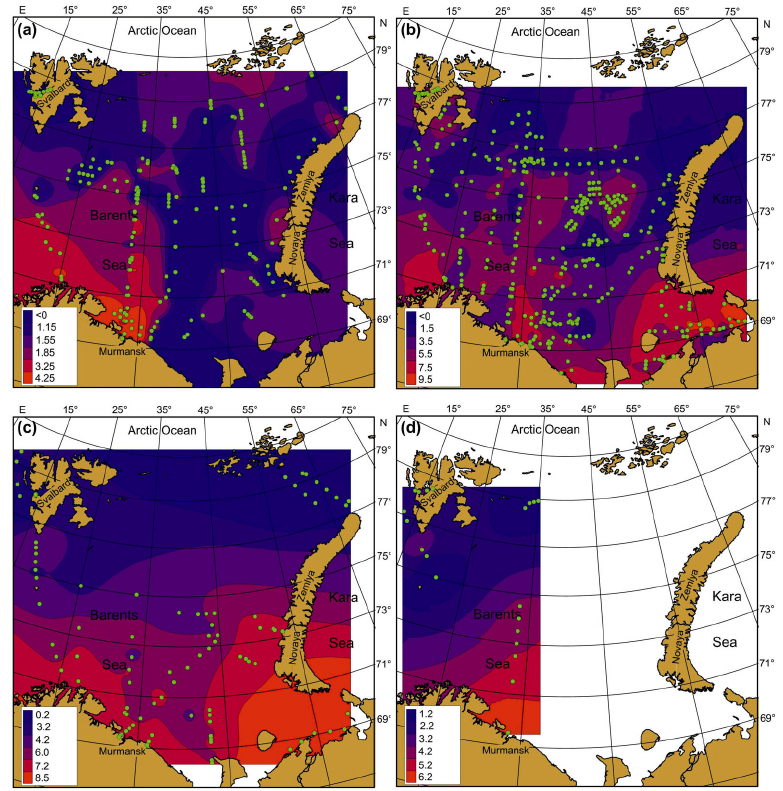
Figure 4. Averaged SST (°C) in the Barents Sea, 1984–2021. ( a )—spring; ( b )—summer; ( c )—autumn; ( d )—winter. Points indicate the location of sampling stations. In summer, SST was in a range of − 0.8–+10.0 °C with maximum values in the coastal regions of the southern and south ‐ eastern areas (Figure 4b). In autumn, SST varied between − 1.7 °C and 10.9 °C, with the highest value in the south ‐ eastern Barents Sea (Figure 4c). In winter, SST ranged from − 1.8 to 7.2 °C, decreasing from the south to the north. Minimum values near zero or just below were typical for most northern areas in all seasons (Figure 4). SSS varied between 8.35 psu and 35.10 psu, and the average values were in a range of 22.0–35.0 psu (Figure 5). SSS patterns were similar in all seasons, with the highest estimations in the central and western regions and minimal SSS in the south ‐ eastern Barents Sea (Figure 5).